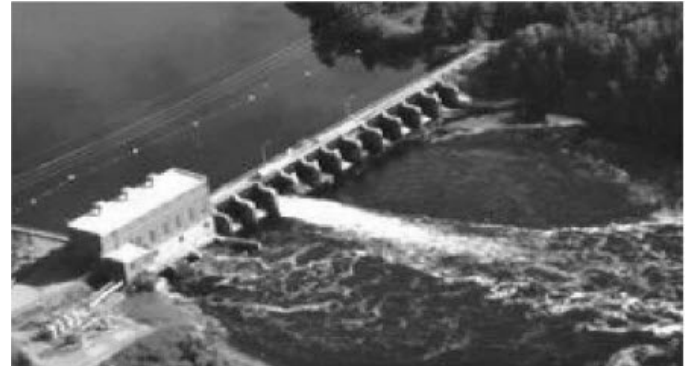
Figure 2. Practical sample of a hydraulic jump below abrupt asymmetric expansion [31]. Reprinted with permission from American Society of Civil Engineers (ASCE).